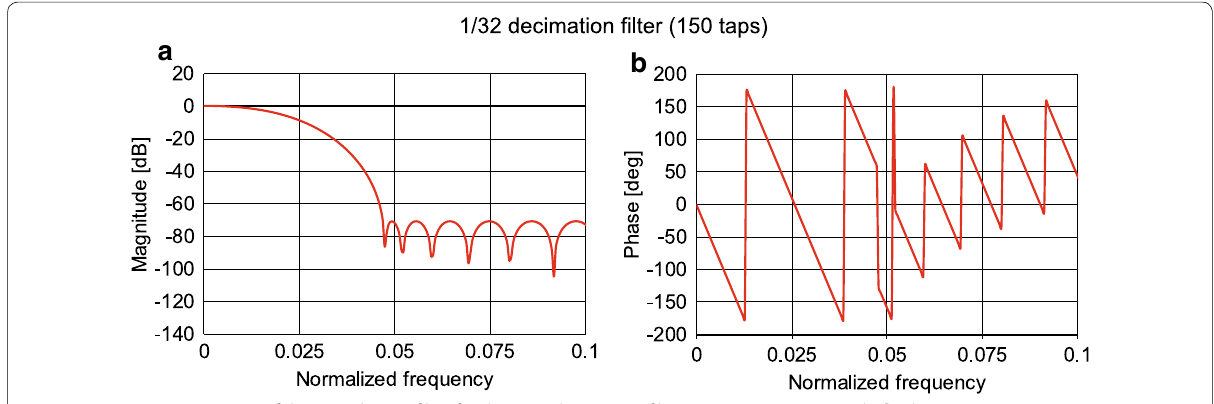
Fig. 10 Frequency responses of the anti-aliasing filter for the 1/32 decimation filter (150 taps). a Magnitude, b